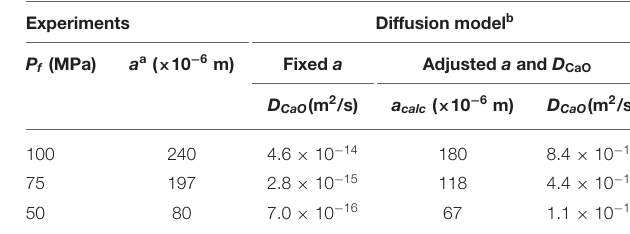
TABLE 3 | Results of the